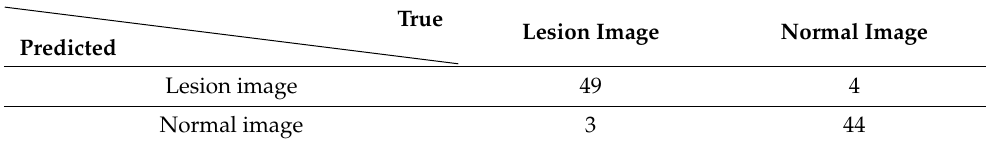
Table 2. Analytical constant images of TSF algorithm screening results.